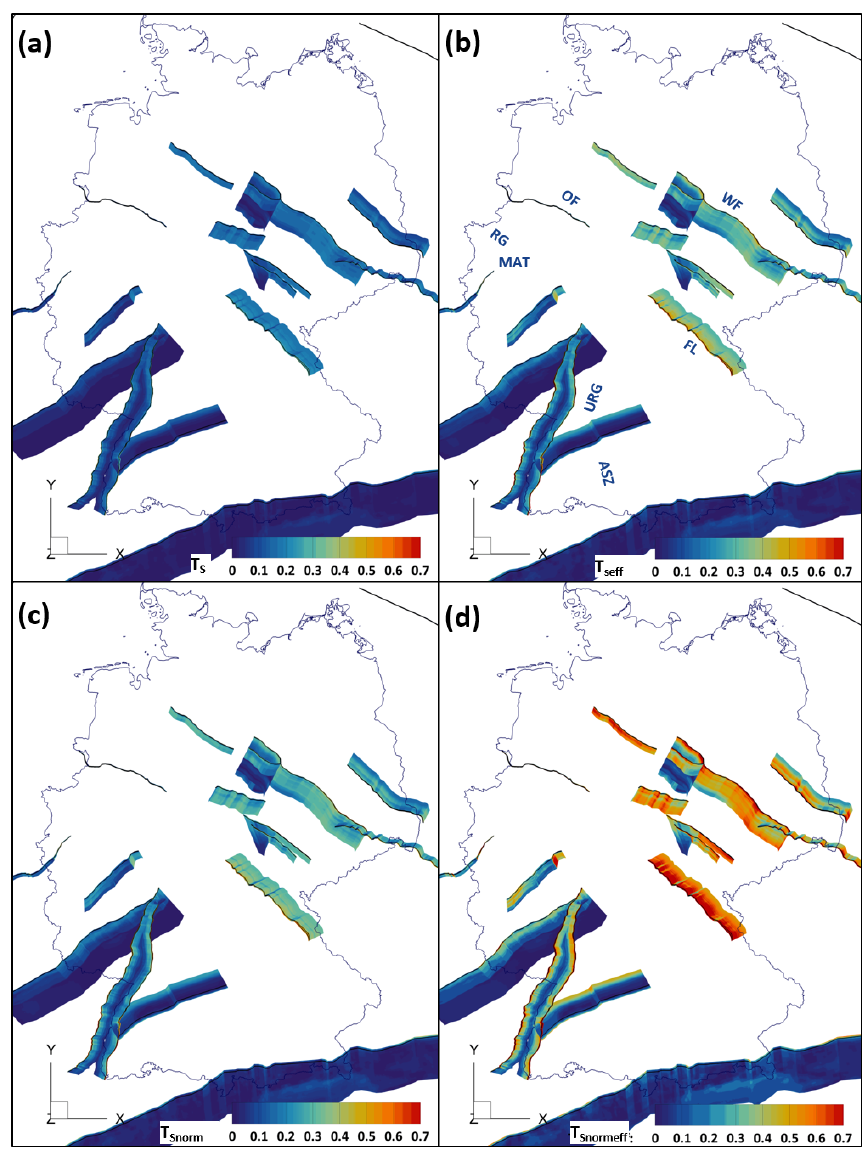
Figure 5. The semi-realistic fault geometries are color-coded by their slip tendency for four cases. (a) T S ; (b) T Seff (with effective normal stresses); (c) T Snorm (normalized to a coefficient of friction of 0.57); (d) T Snormeff (with effective normal stresses and normalized to a coefficient of friction of 0.57). ASZ: Albstadt Shear Zone; FL: Franconian Line; MAT: Midi-Aachen Thrust; OF: Osning Fault; URG: Upper Rhine Graben; RG: Roer Valley Graben; WF: Wittenberg Fault. ©EuroGeographics for the administrative